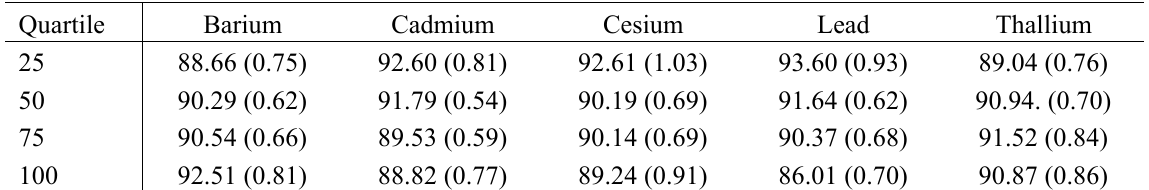
Table 6. Waist Circumference by Metal Quartiles for All